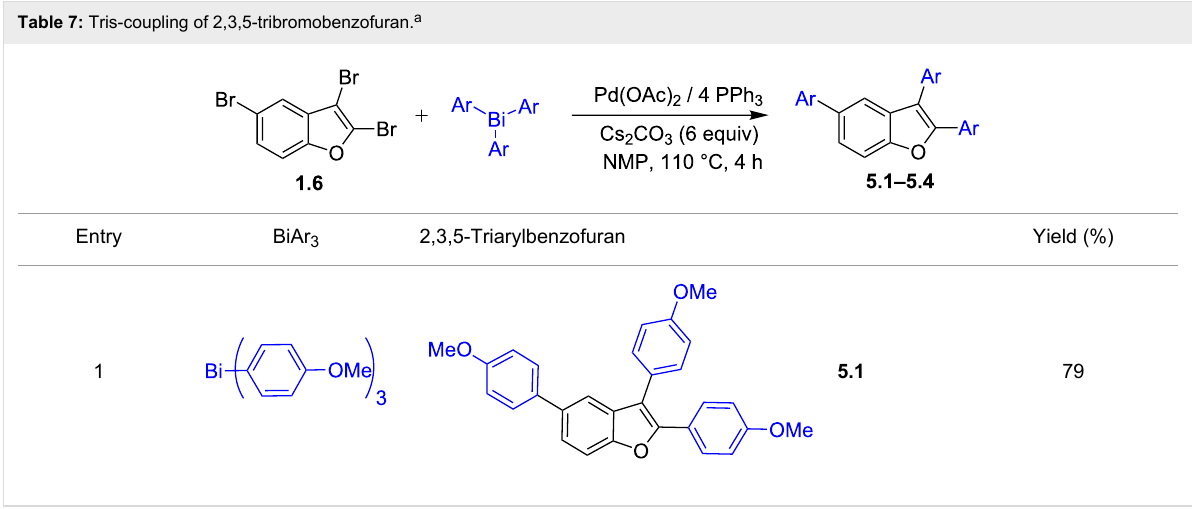
Table 7: Tris-coupling of 2,3,5-tribromobenzofuran.